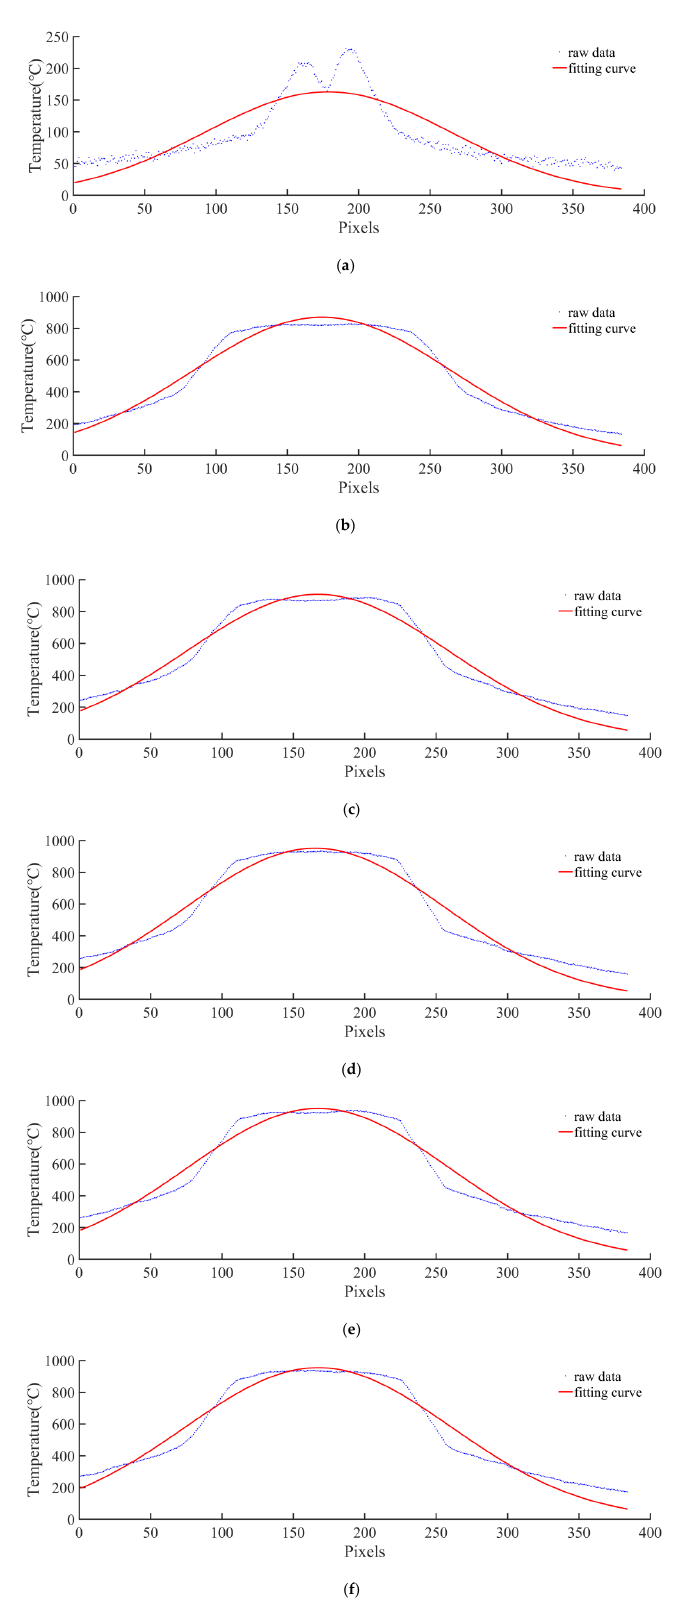
Figure 6. Gaussian fitting results of the temperature distribution of the weldment surface perpendicular to the welding direction at different times: ( a ) t = 4 s; ( b ) t = 8 s; ( c ) t = 12 s; ( d ) t = 20 s; ( e ) t = 25 s; ( f ) t = 29 s. The mean absolute error of fitting the original temperature distribution data of the weldment surface perpendicular to the welding direction by quadratic fitting, cubic fit- ting, and Gaussian fitting is shown in Table 2.